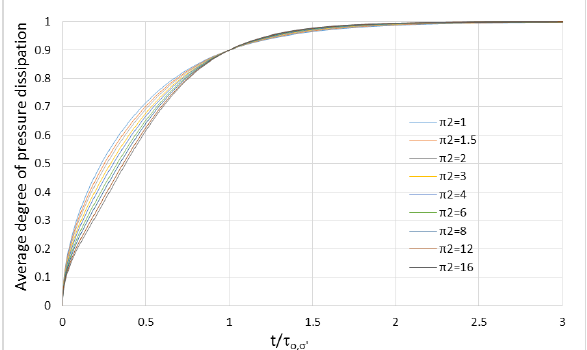
Fig. 3 Evolution of average degree of pressure dissipation for the extended Davis and Raymond model with both non-constant c v and 1+e and variable dz